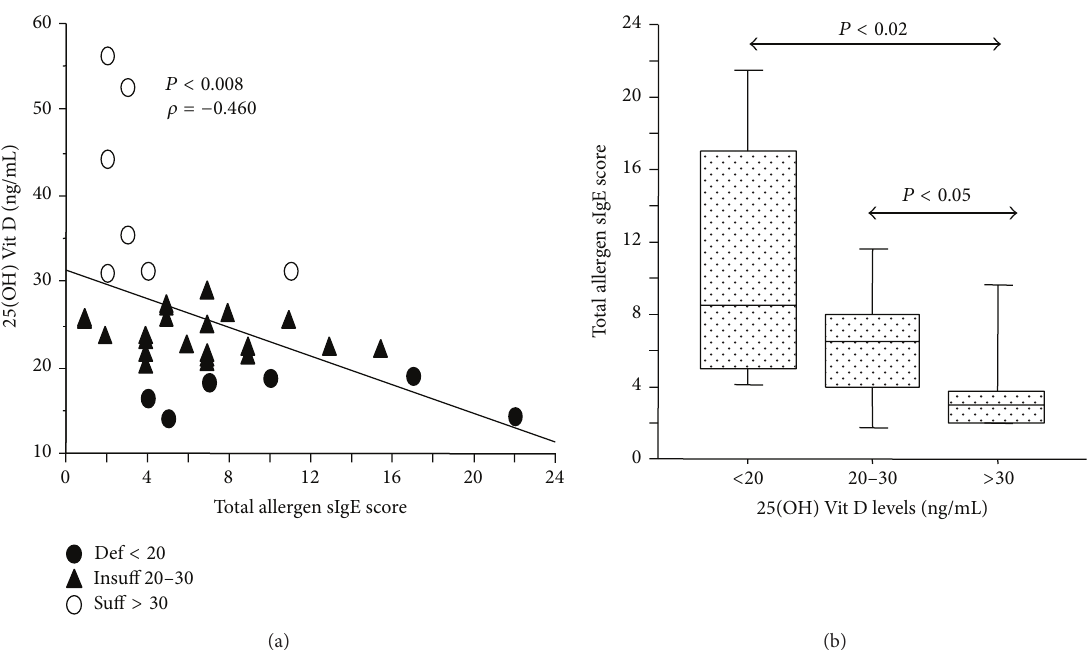
Figure 5: Relationship between 25(OH) Vit D plasma levels and total allergen sIgE score in patients with AAR ( 𝑛 = 35 ). (a) 25(OH) Vit D levels and total allergen sIgE score inversely correlated in AAR patients. Statistical analysis was performed by Spearman rank test. (b) Total allergen sIgE score in AAR patients with deficient ( 𝑛 = 6 ), insufficient ( 𝑛 = 22 ), or sufficient ( 𝑛 = 7 ) 25(OH) Vit D levels. Bars in the box plots indicate (from the bottom to the top) 10th, 25th, 50th (median), 75th, and 90th percentiles. Statistical analysis was performed by Kruskal-Wallis test and Mann-Whitney U test. Significance was accepted at 𝑃 < 0.05 .